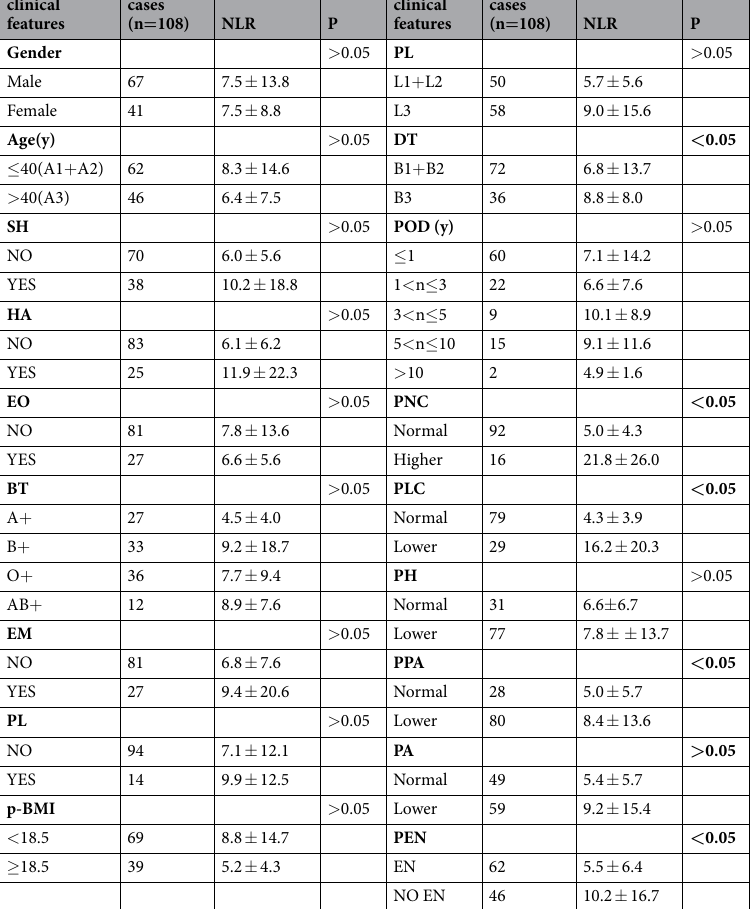
Table 2. Distributions of NLR according to clinical features. SH , smoking history; HA , history of appendectomy; POD , preoperative duration; PL , primary lesion; DT , disease type (B3 or not); EM ,